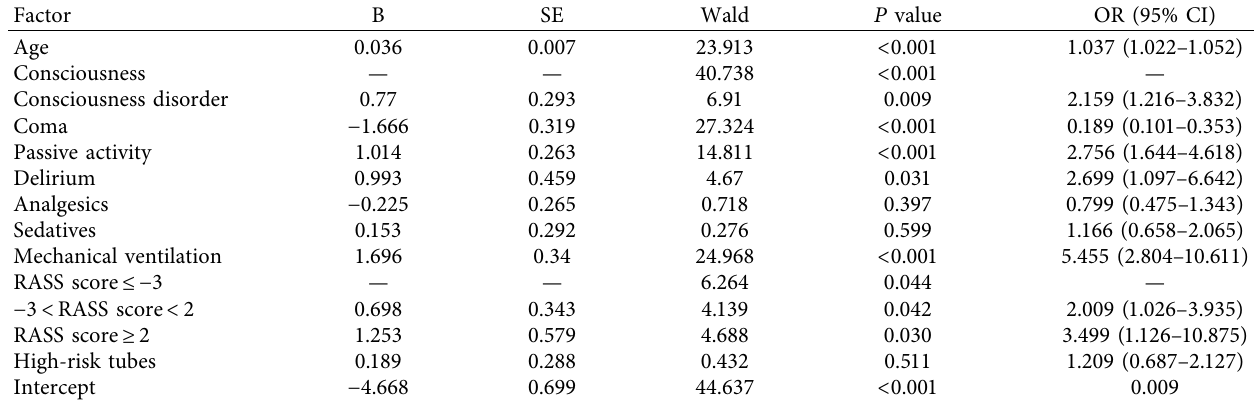
Table 2: Logistic regression analysis of factors infuencing the use of physical restraint.